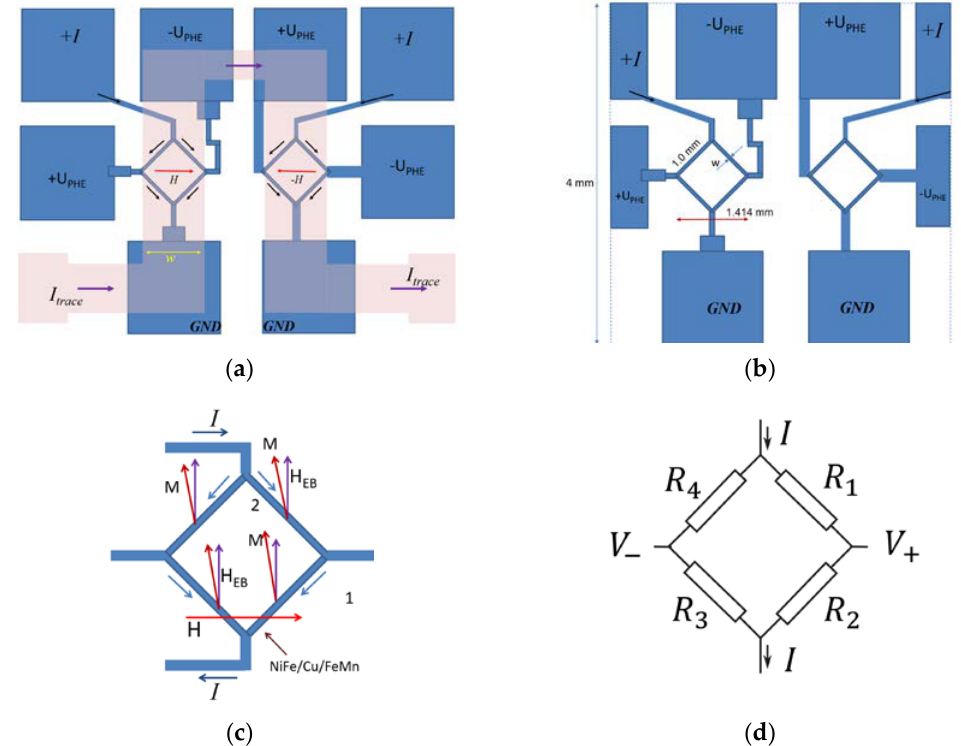
Figure 5. Layout of the exchange biased AMR bridge sensor chip: ( a ) Chip layout with over imposed U-shaped current trace on top of the AMR bridges; ( b ) Dimensions of the chip; ( c ) Working principle of the AMR bridge sensor; ( d ) Equivalent circuit of a single AMR bridge sensor. Note that the structured is within a square of 4 × 4 mm 2 and was realized on a 5 × 5 mm 2 chip. The margins are 0.5 mm while the arm of the bridge has a length L = 1 mm and a width of either 0.1 or 0.2 mm. The contacting pads size can be reduced such that the chip can fit inside a 3 × 3 mm 2 footprint.